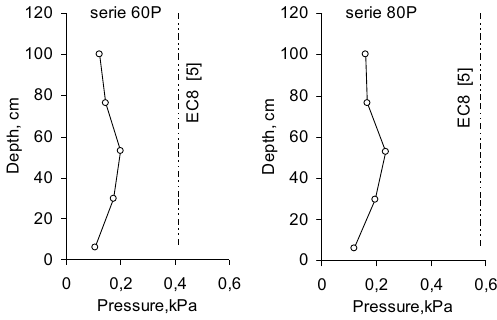
Fig. 9. Distribution of maximal dynamic pressures for P